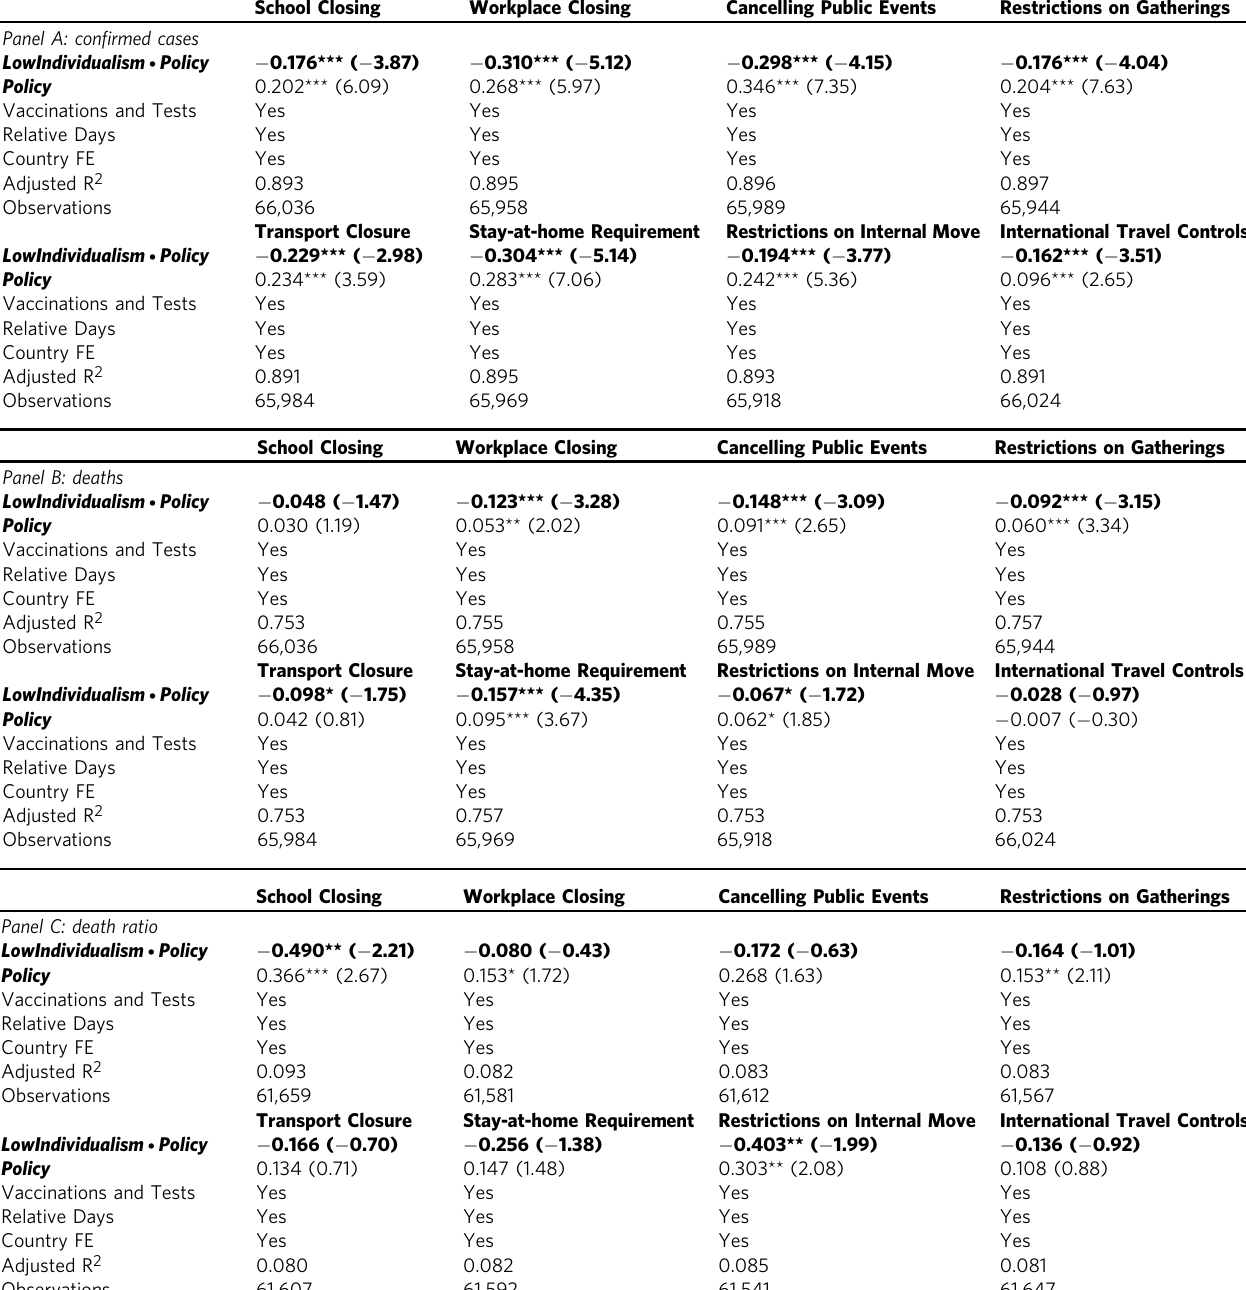
Table 2 Effectiveness of virus- fi ghting policies and individualism in an international setting (from Jan 1, 2020 to Dec 31, 2021). School Closing Workplace Closing Cancelling Public Events Restrictions on Gatherings Panel A: con fi rmed cases LowIndividualism ∙ Policy